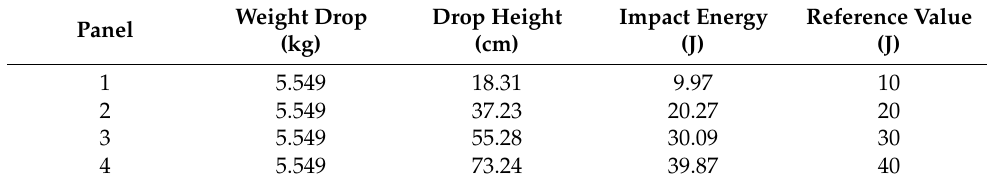
Table 2. Impact energies (J) applied to the prepreg panels by vertical drop in weight.